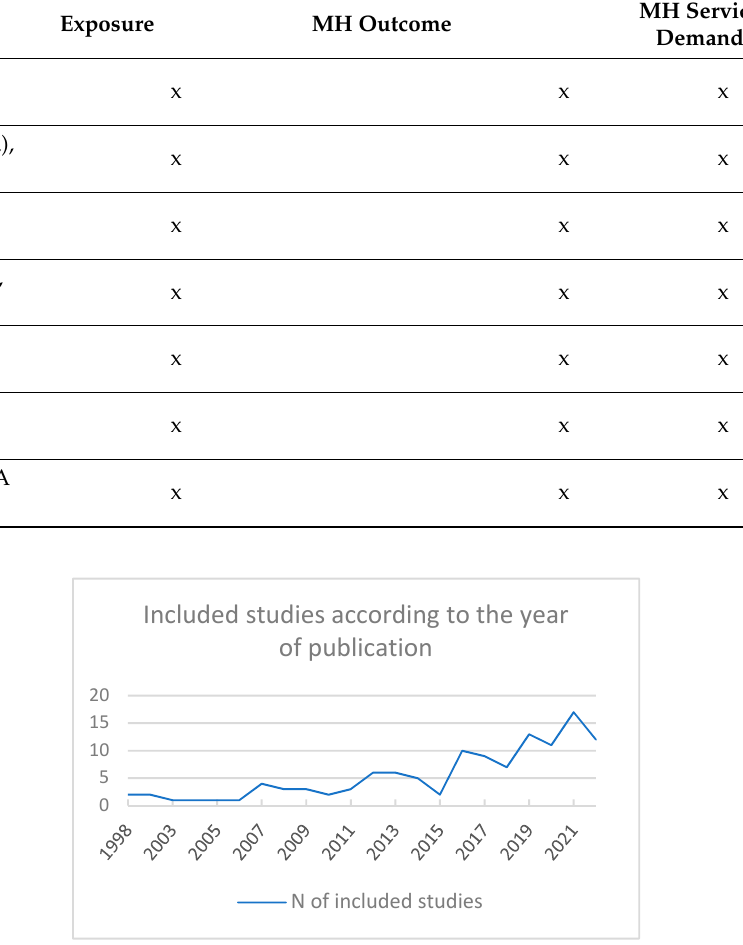
Figure 2. Included studies according to the year of publication. Twenty-nine studies (27.5%) were carried out in low- and middle-income countries.